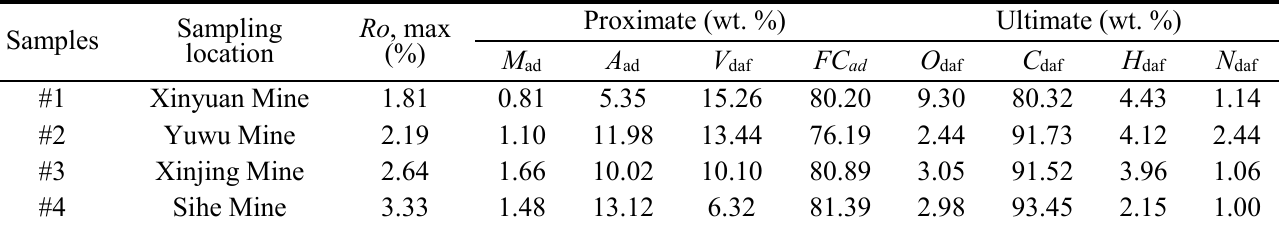
Table 1—Properties of the coals